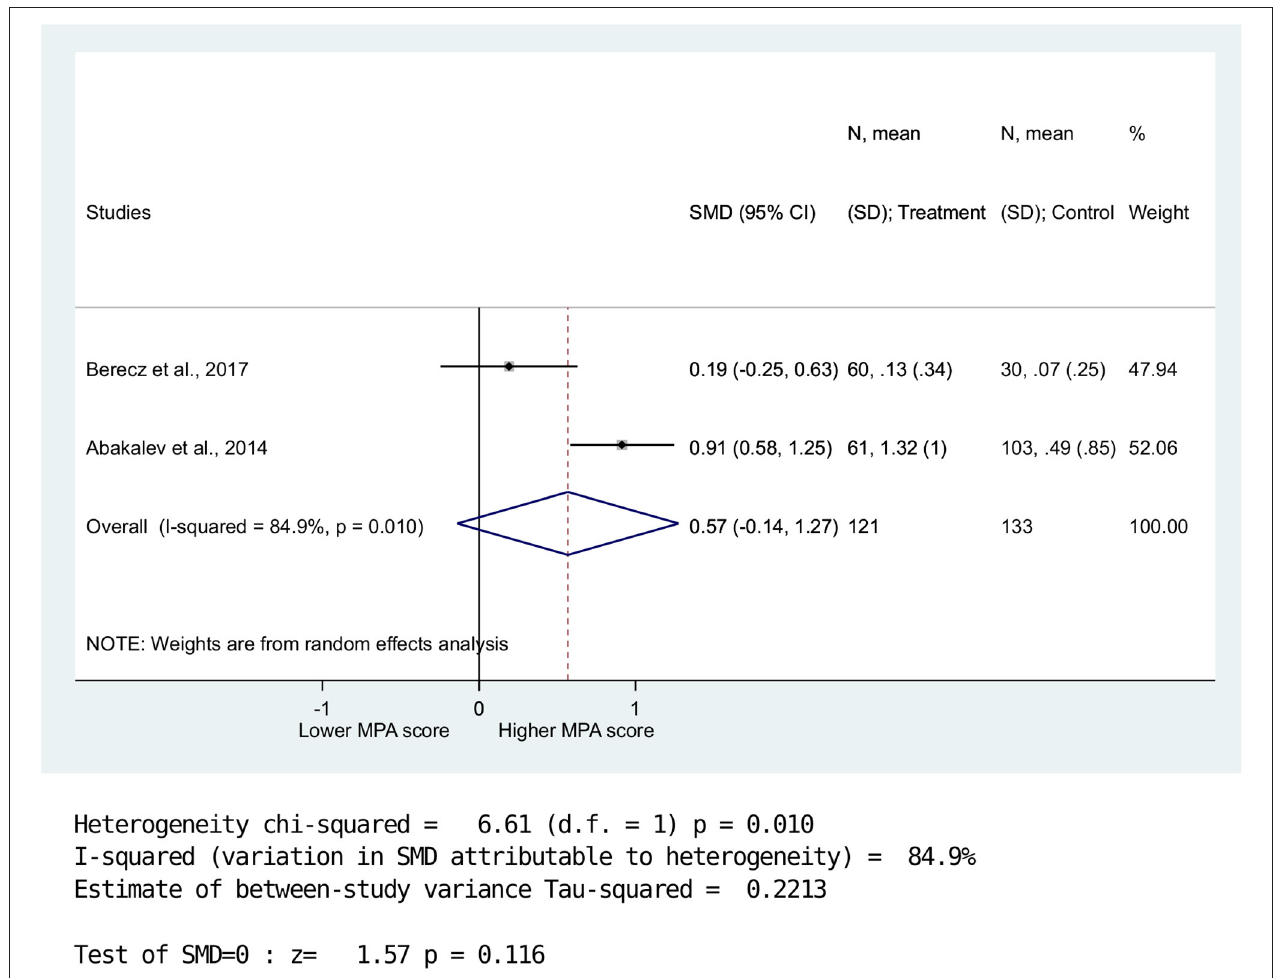
FIGURE 3 | Standardized mean difference of minor physical anomalies in the peripheral regions in patients with bipolar disorders vs. healthy controls. There was no significant between-group difference between BPD and HC in MPA-P scores. (SMD = 0.57,95%; CI: − 0.14-1.27, p = 0.116).